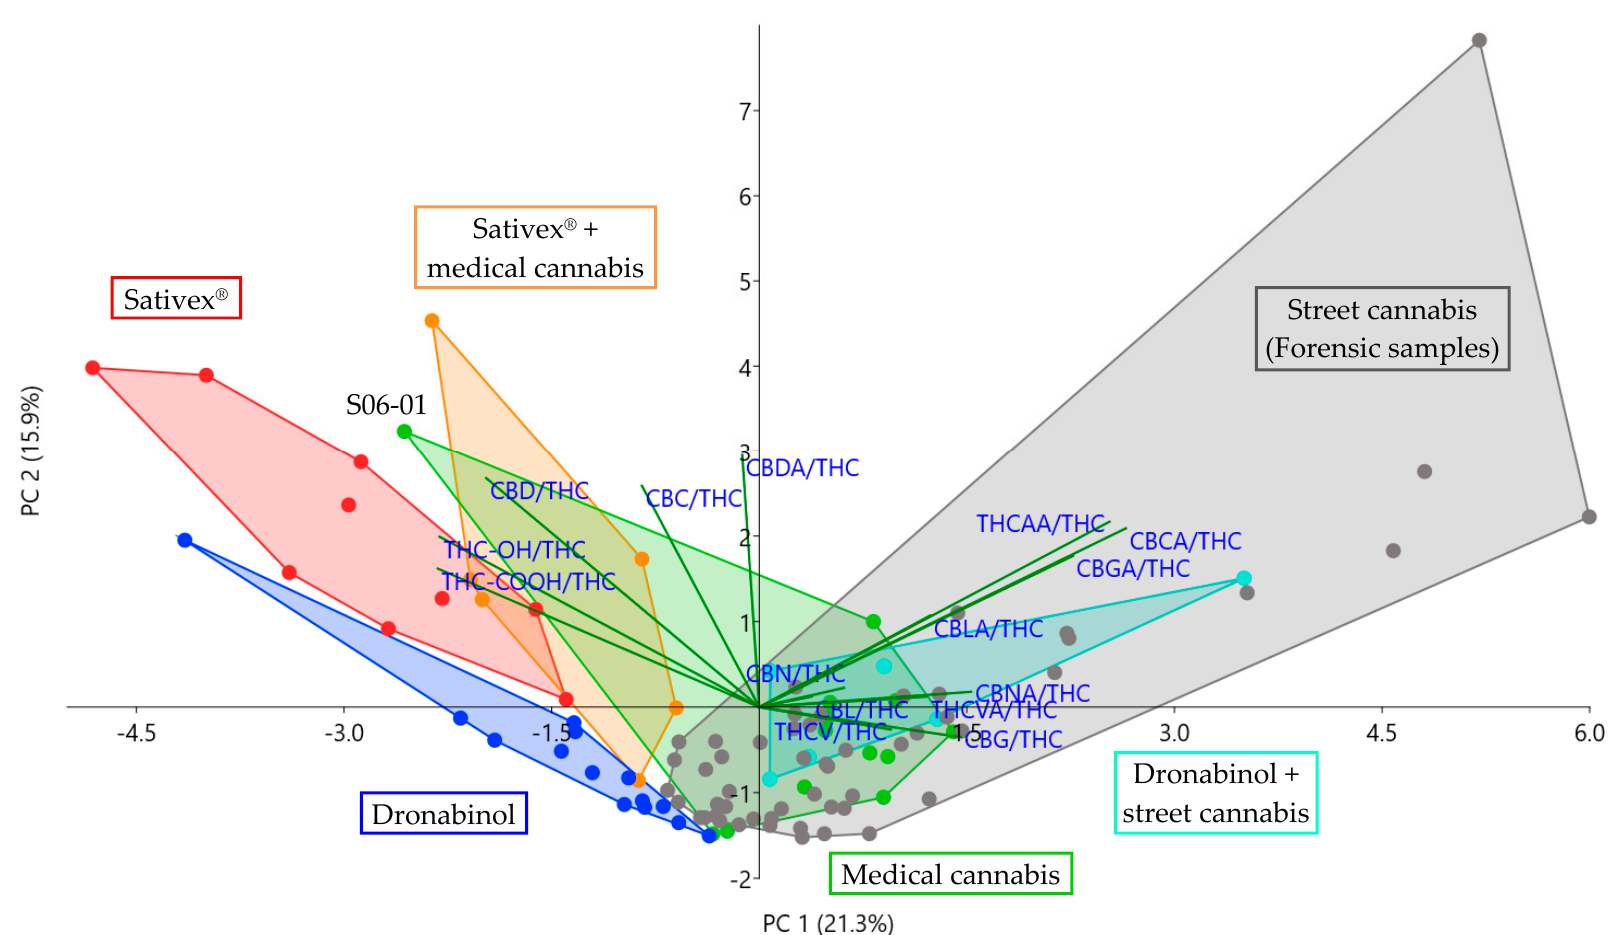
Figure 2. Sample subgroups separated in the PCA biplot of principal component (PC) 1 and PC 2 with loadings expressed as vectors. The orientation of a vector illustrates which PC Table 1. and the positive axis of PC 2. The further away a vector from the origin of a PC is, the higher the loading on the PC. Samples of Dronabinol and Sativex ® users are separated from street cannabis users, indicating different serum cannabinoid patterns. Samples from users of street cannabis, medical cannabis or Dronabinol and street cannabis are mostly plotted in the same area, indicating similar serum cannabinoid patterns, except for sample S06-01 from a user of the CBD-rich strain Bediol ® .